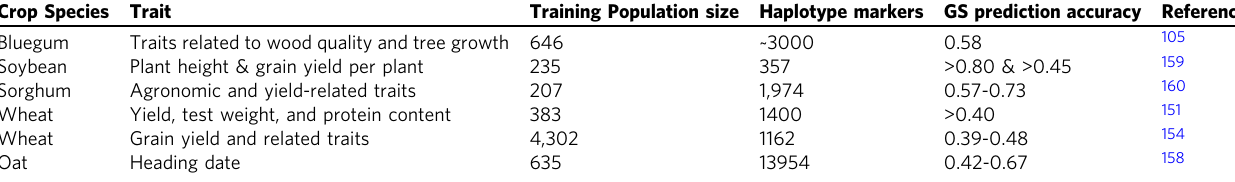
Table 2 The use of haplotype markers in genomic selection in different crop species. Crop Species